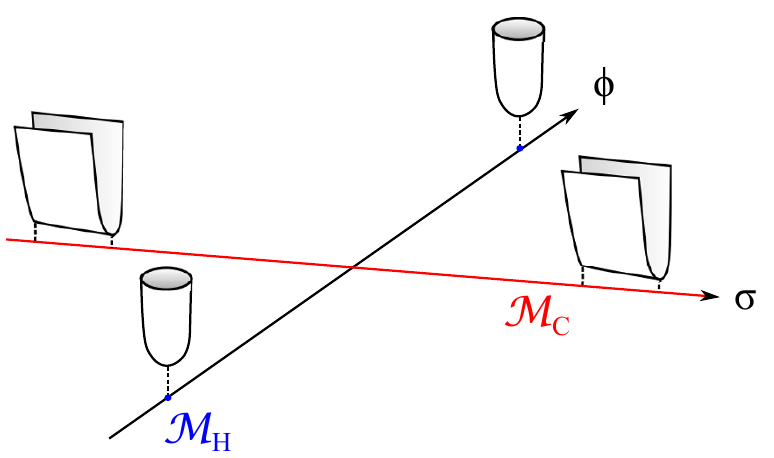
Figure 4 . This (cid:12)gure illustrates the behavior of the potentials on the Higgs (blue) and Coulomb (red)